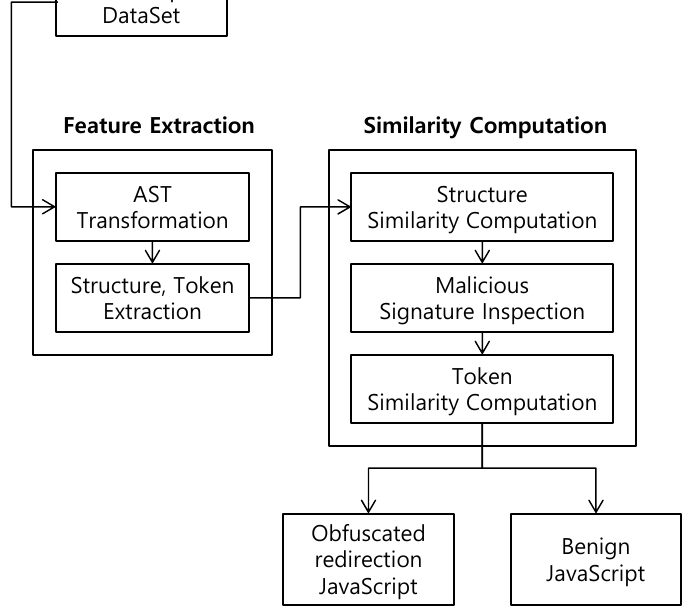
Figure 1. Proposed system.